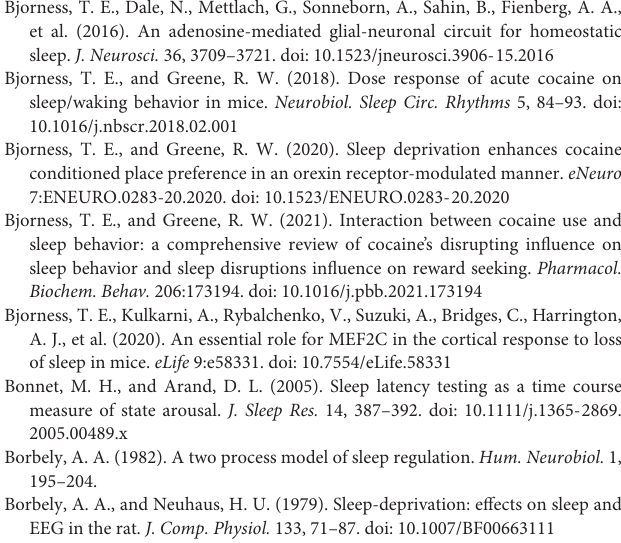
(B) , REML (C) , and gamma energy during waking relative to baseline measures [ (D) ; cocaine n = 6, saline n = 5]. P and F values and statistics for all pairwise comparisons with significant difference or trends toward significance are given in Supplementary Table 7